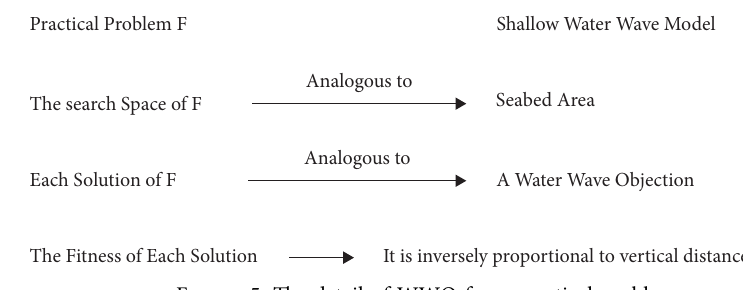
Figure 5: The detail of WWO for a practical problem.